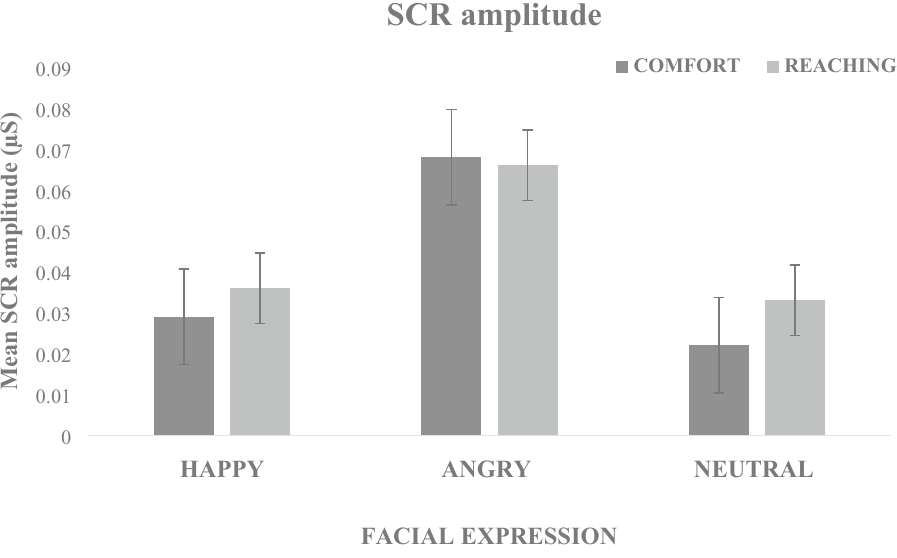
Figure 1. Effect of Facial expression on SCR amplitude. The graph shows the mean SCRs amplitude (μS) as a function of the three facial expressions (Happy-Angry-Neutral) in the comfort- and reaching-distance tasks. Error bars represent the standard